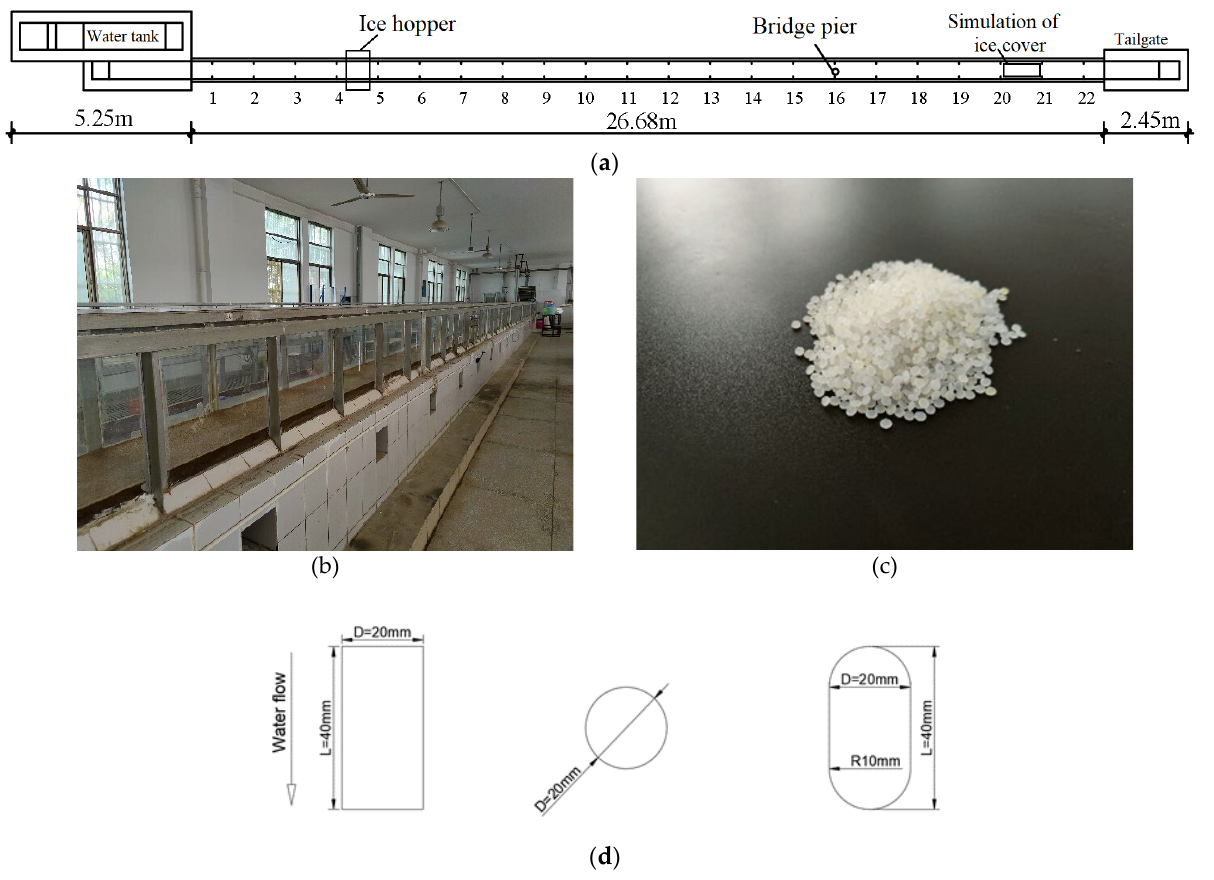
Figure 1. ( a , b ) Flume layout for experiment; ( c ) polyethylene particles; ( d ) cross section of model piers.